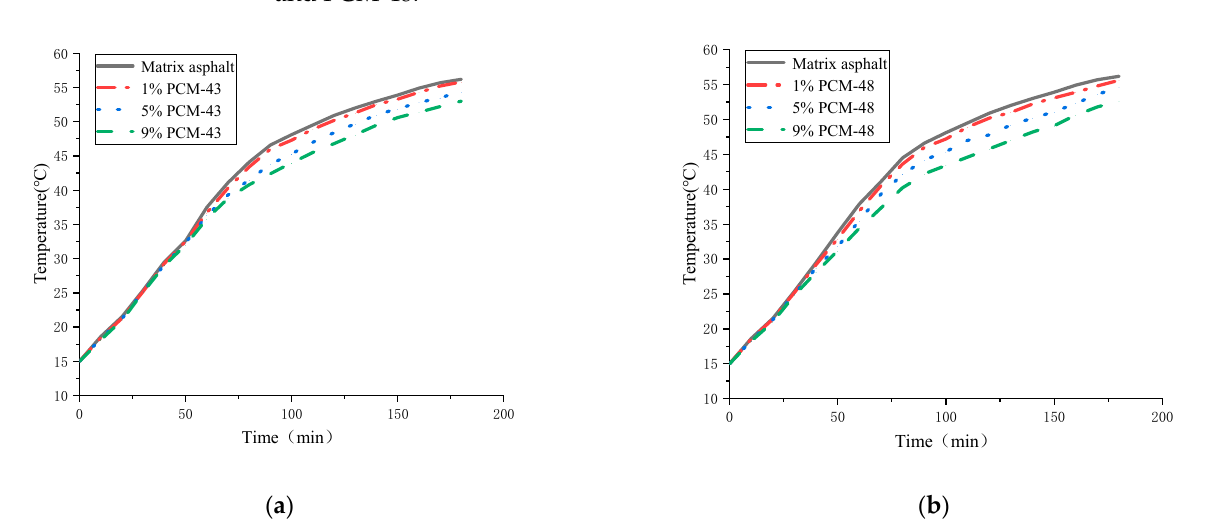
Figure 7. Rutting factor of asphalt with different dosages of PCM: ( a ) PCM-43; ( b ) PCM-48.